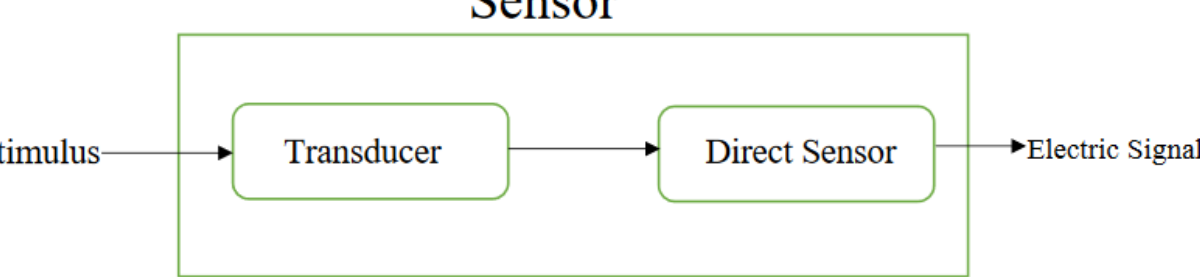
Figure 14. A sensor’s input and output signals are shown in a schematic diagram.